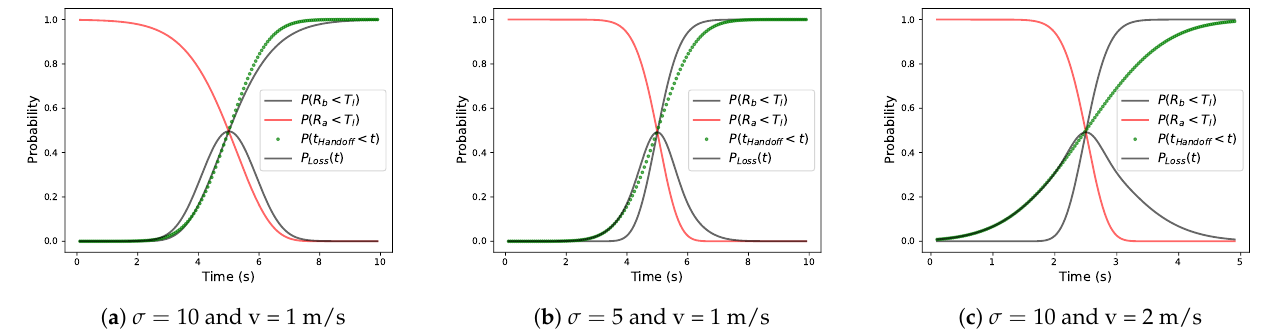
Figure 6. Probability of packet loss, disconnections of individual links, and handoff in time. Com- paring figures ( a , b ), we can observe higher packet loss probability stemming from fluctuations in the link quality. Comparing Figures ( a , c ), the higher packet loss probability is stemming from the increased